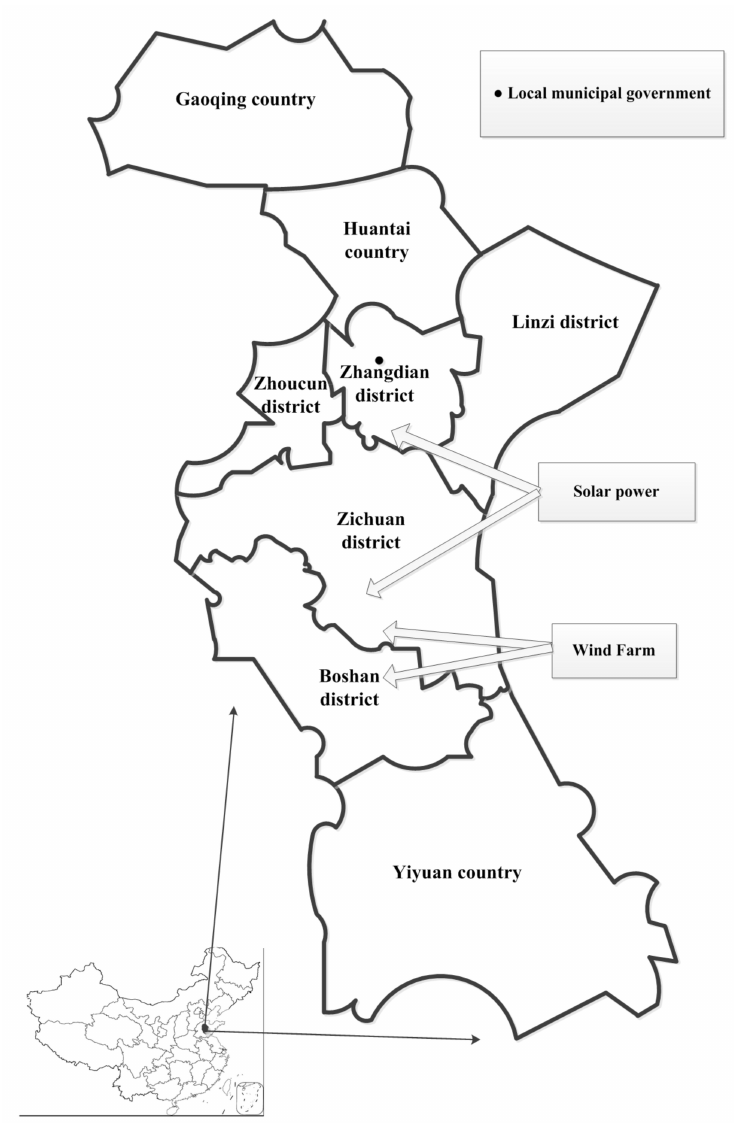
Figure 1. Location of the study area and regional energy resources